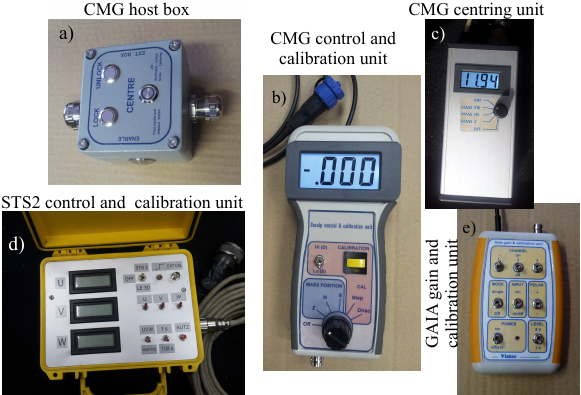
Figure 7. Control and calibration units developed for the broadband seismometers and the GAIA DAS to guarantee the high quality of recorded